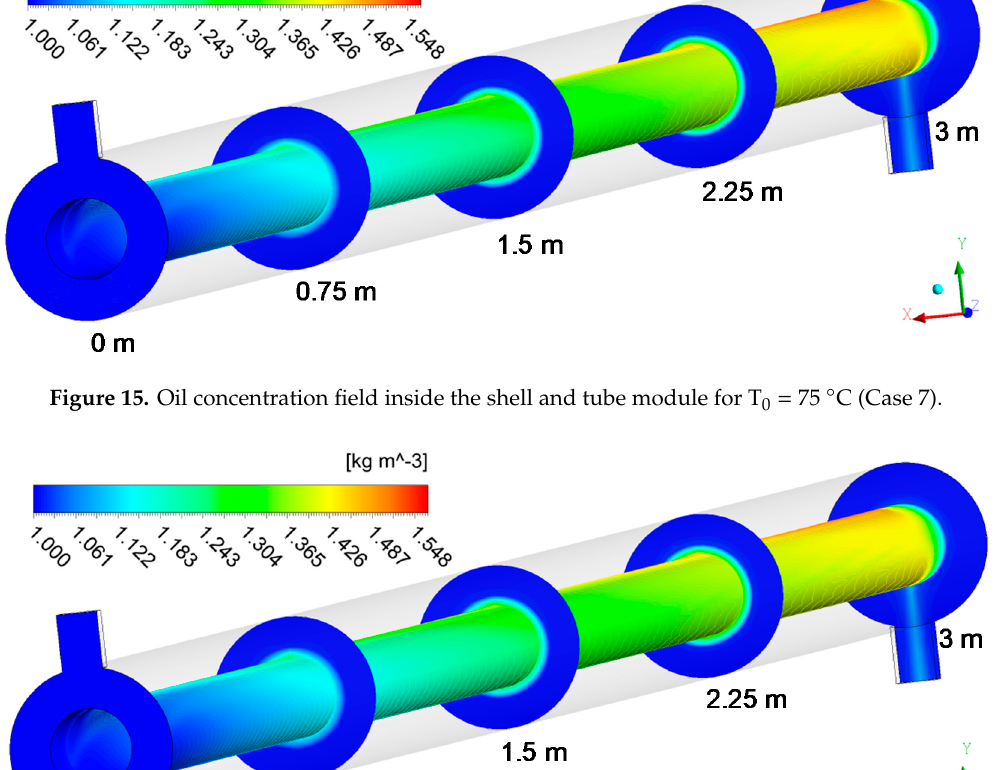
Figure 16. Oil concentration field inside the shell and tube module for T 0 = 95 °C (Case 8).